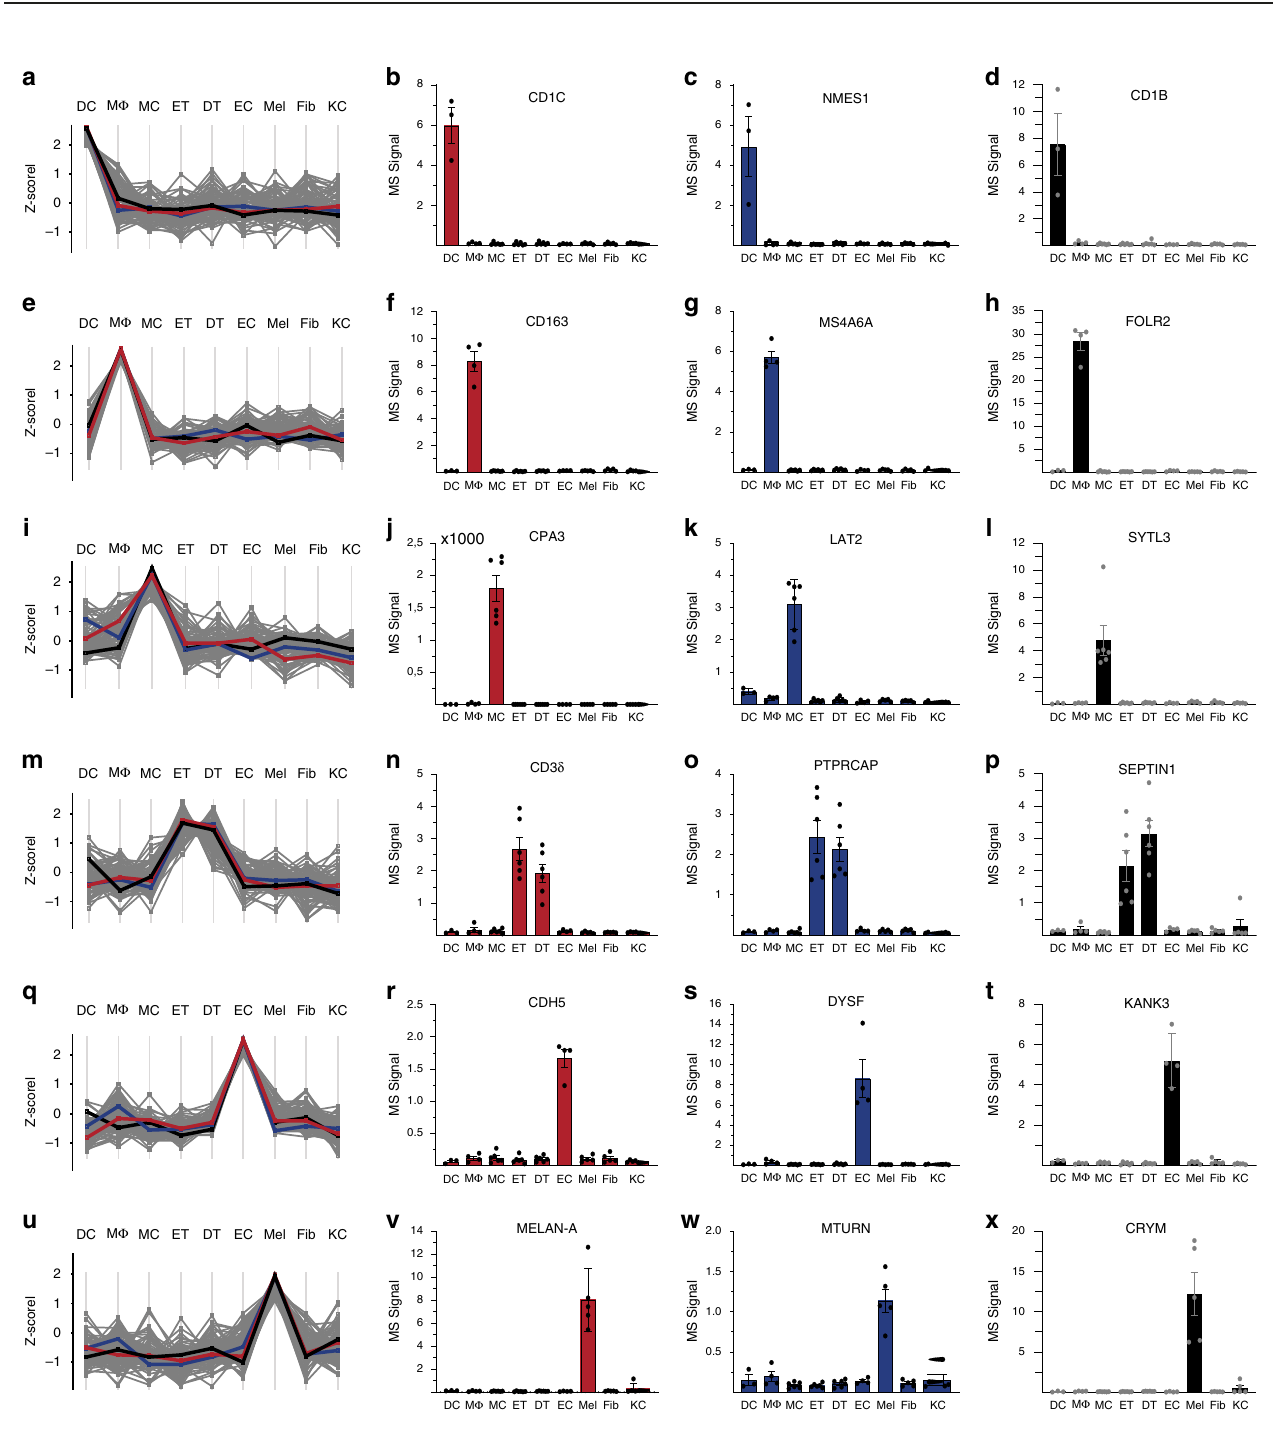
Fig. 5 In-depth MS-based proteomic analysis of skin-associated cellular subsets. a Single-run analyses of DC; CD1A + dendritic cells ( N = 3), M Φ ; macrophages ( N = 4), MC; mast cells ( N = 6), ET; epidermal T cells ( N = 6), DT; dermal T cells ( N = 6), EC; endothelial cells ( N = 4), Mel; melanocytes ( N = 5), Fib; fi broblasts ( N = 5) and KC; keratinocytes ( N = 5) using data-independent (DIA) acquisition. Data are presented as mean±SEM. N represents number of biologically independent samples. The number of quanti fi ed protein groups for each major cell lineage is roughly similar. Source data are provided as a Source Data fi le. b Principal component analysis (PCA) of all proteomes from cellular subsets. Color code from panel ( a ). The PCA separates cultivated fi broblast and keratinocytes from FACS-sorted endothelial cells (EC) and melanocytes (Mel) as well as from the immune cells, as indicated by enclosing ovals. c Heatmap of protein abundances of 1272 differentially expressed proteins (ANOVA, FDR < 0.01, FCH > 2) after unsupervised hierarchical clustering. d Differentially expressed proteins in epidermal T cells vs. dermal T cells (volcano plot, FDR < 0.05, FCH >